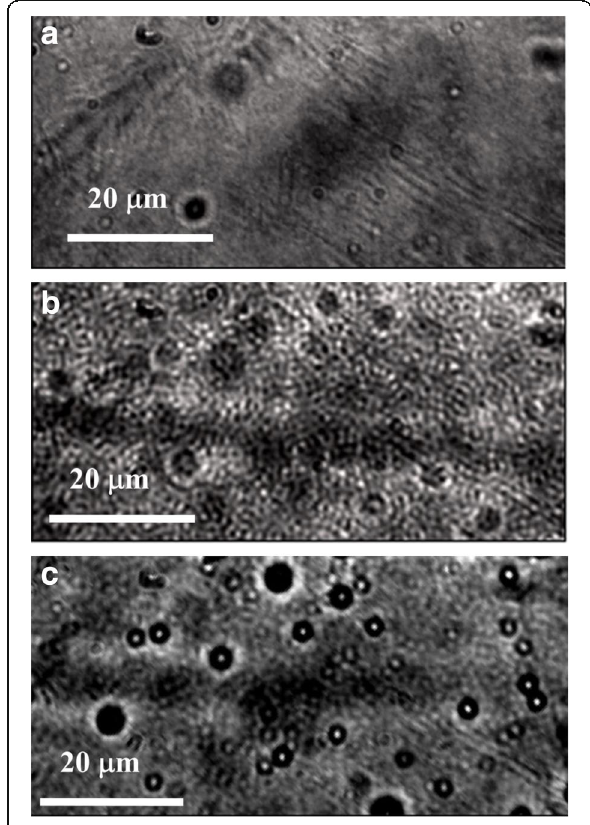
Fig. 4 Optical micrographs of a neat P3HT and b , c P3HT:PMMA films with b 10 wt% and c 2 wt% of P3HT in